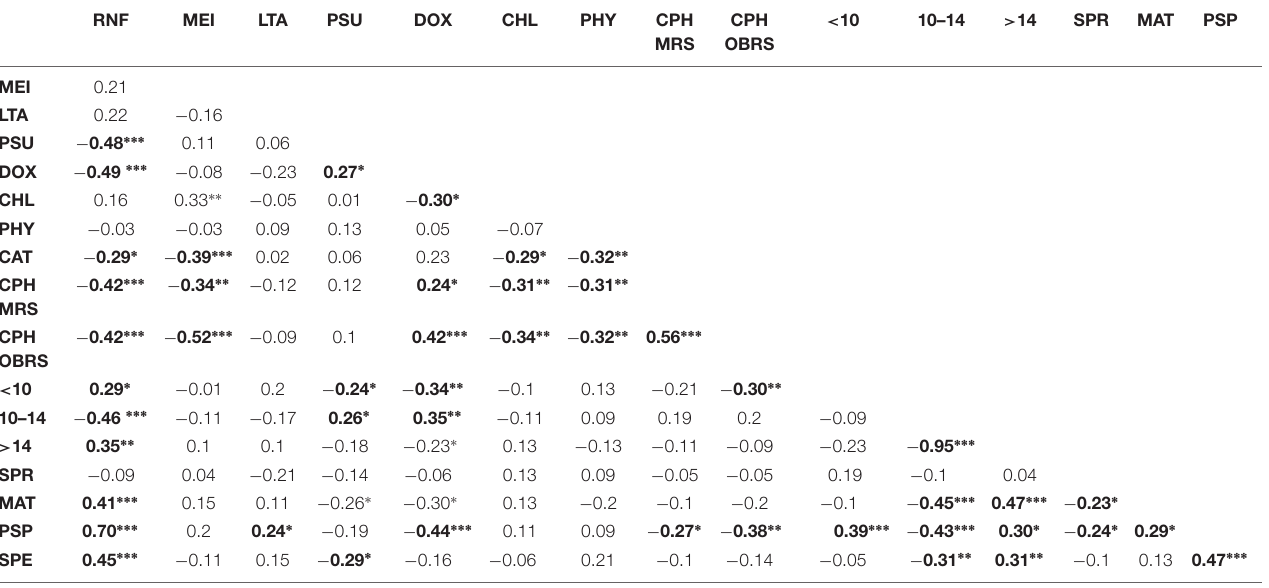
TABLE 3 | Pearson correlation matrix ( r -values and significance) between oil sardine catch, catch rates, size groups, maturity stages and environmental